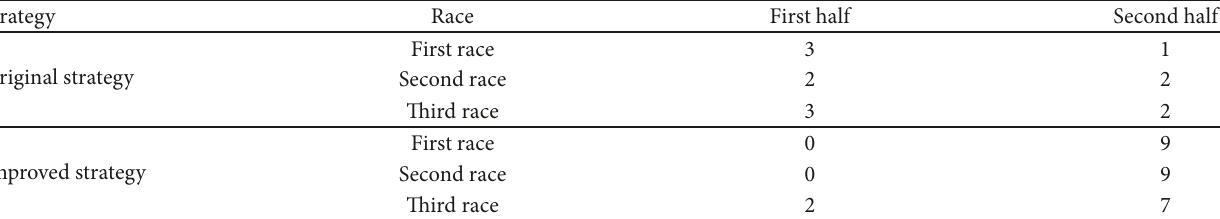
Table 2: The data of the race.